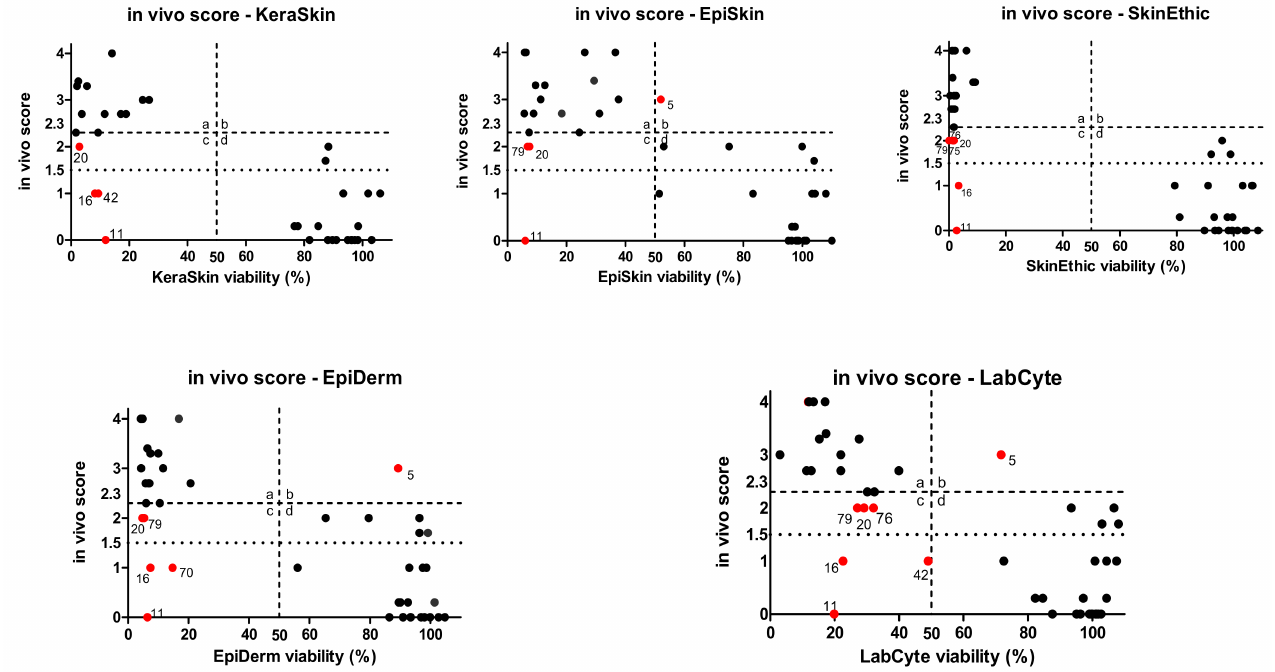
Figure 6. Relationship between in vivo scores and viability data of OECD TG 439 The cut-off of cell viability was defined as 50%, and the cut off in vivo score was defined as 2.3. The red dots are incorrectly predicted. In vitro irritant (I) = a, c area; in vitro non-irritant (NI) = b, d area; in vivo irritant (I) = a, b area; in vivo non-irritant (NI) = c, d